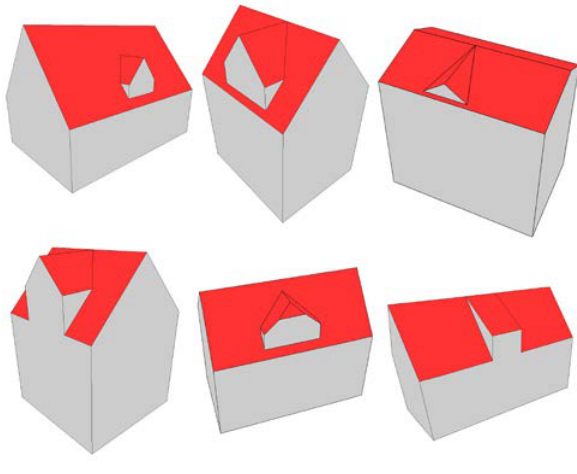
Figure 13. Reconstructed buildings with different roof dormer types (gabled, eyebrow, partial hipped, and